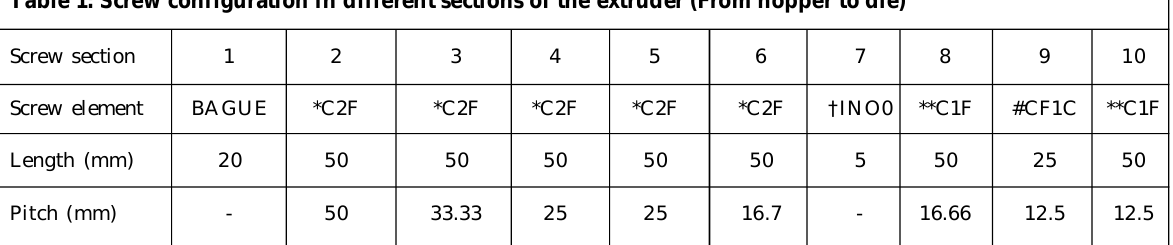
Table 1: Screw configuration in different sections of the extruder (From hopper to